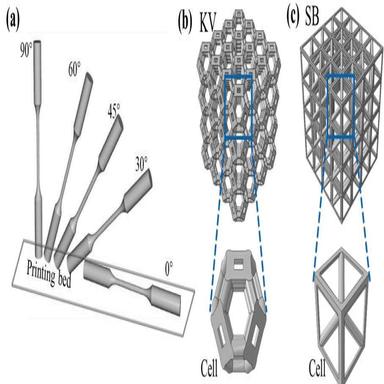
Fabrication of specimens:(a) Schematic diagram and cylindrical tensile samples printed at different angles relative to the printing bed; (b) KV lattice structure; and (c) SB lattice structure.